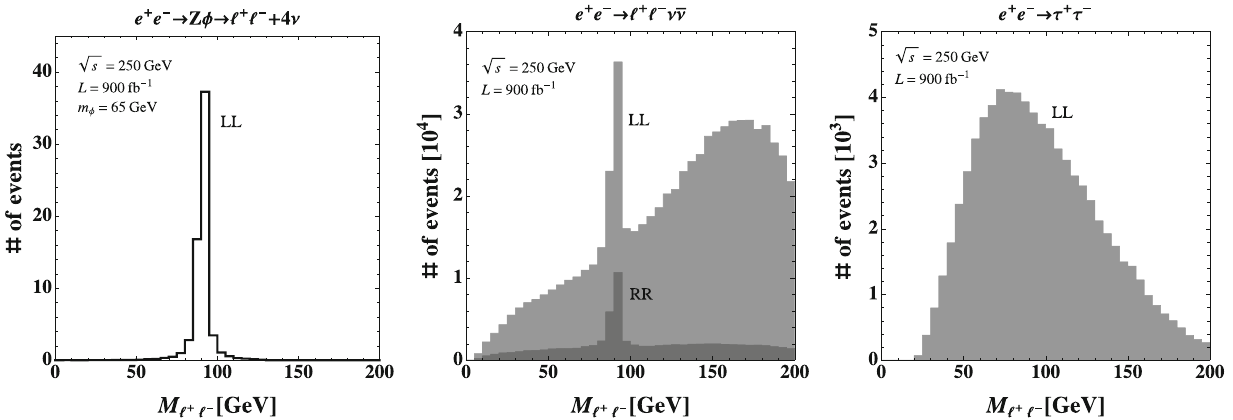
Fig. 6 Distribution of invariant mass for (cid:18) + (cid:18) − with only basic cuts where left-, middle- and right-panels correspond to signal, (cid:18) + (cid:18) − ν ¯ ν BG and τ + τ − BG events. Here κ α = 1 is